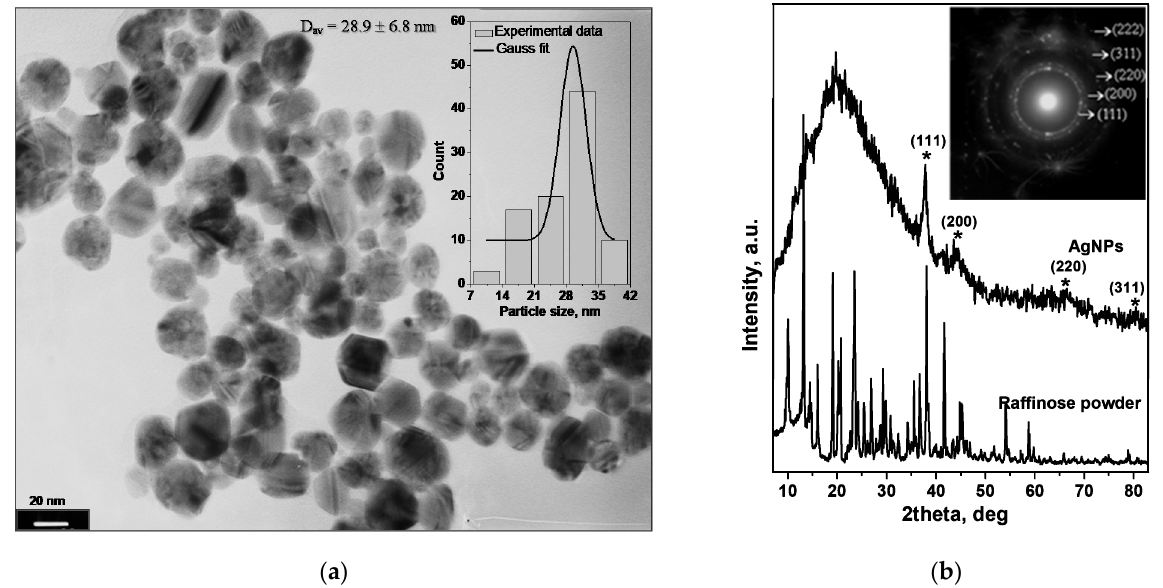
Figure 2. ( a ) TEM micrograph of raffinose capped silver nanoparticles (inset: size distribution histogram); ( b ) X-ray diffraction patterns of raffinose powder and layer of raffinose capped silver nanoparticles, dried on glass support (inset: Selected area electron diffraction (SAED) pattern obtained from TEM observations), “*”—diffraction peaks of Ag/Raff NPs.